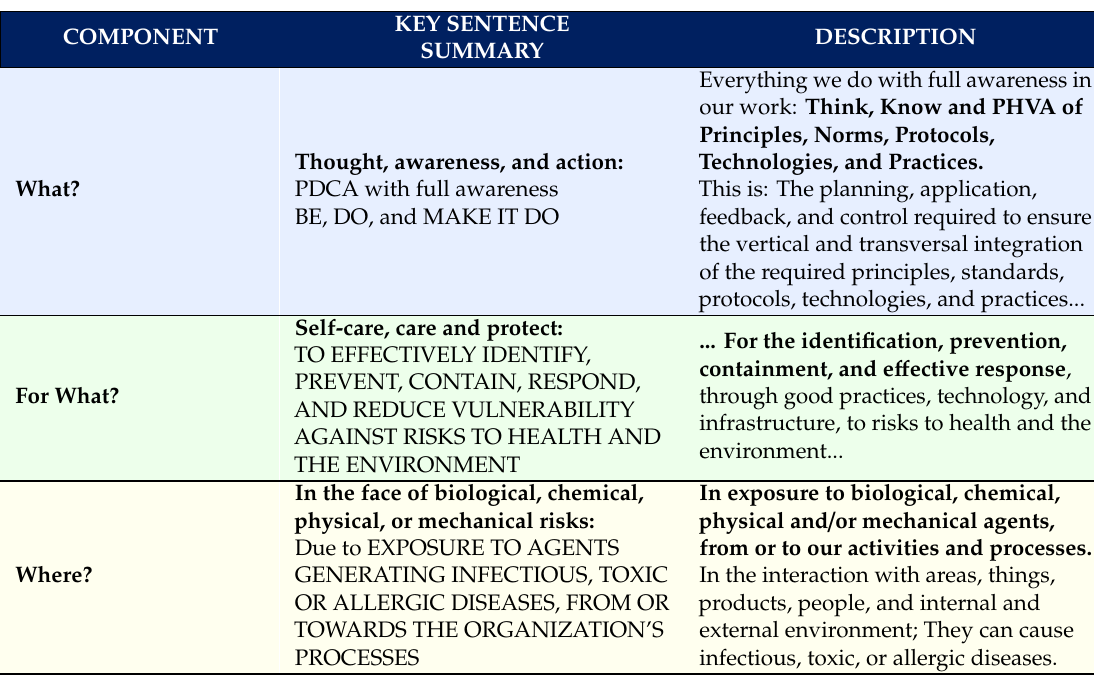
Table 1. Characteristics of comprehensive management for biosecurity based on CDC, BMBL, INSST, ILO, and WHO